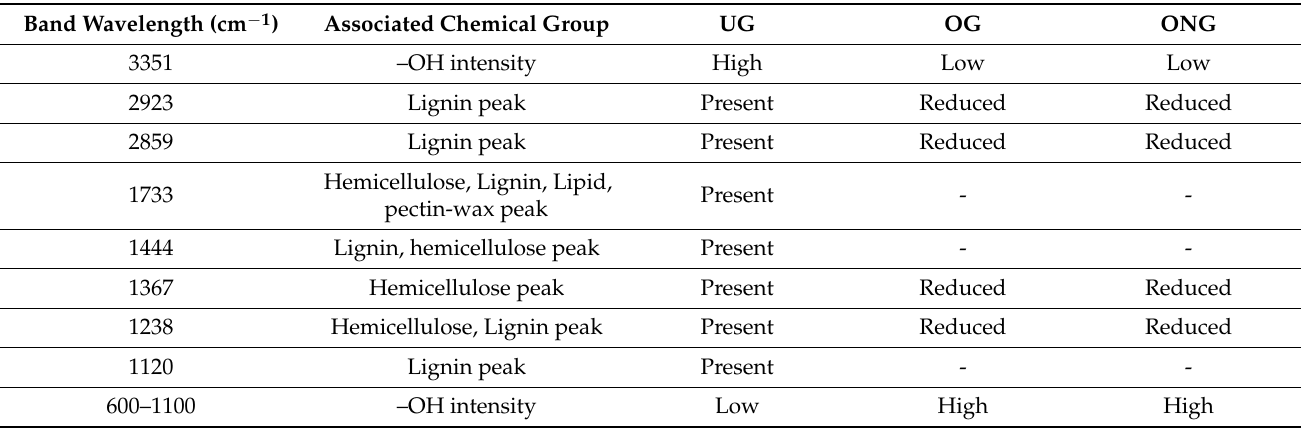
Figure 2. FTIR Spectra of a) UG (green), b) OG (red) and c) ONG (black). Table 4. FTIR results of UG, OG and ONG.